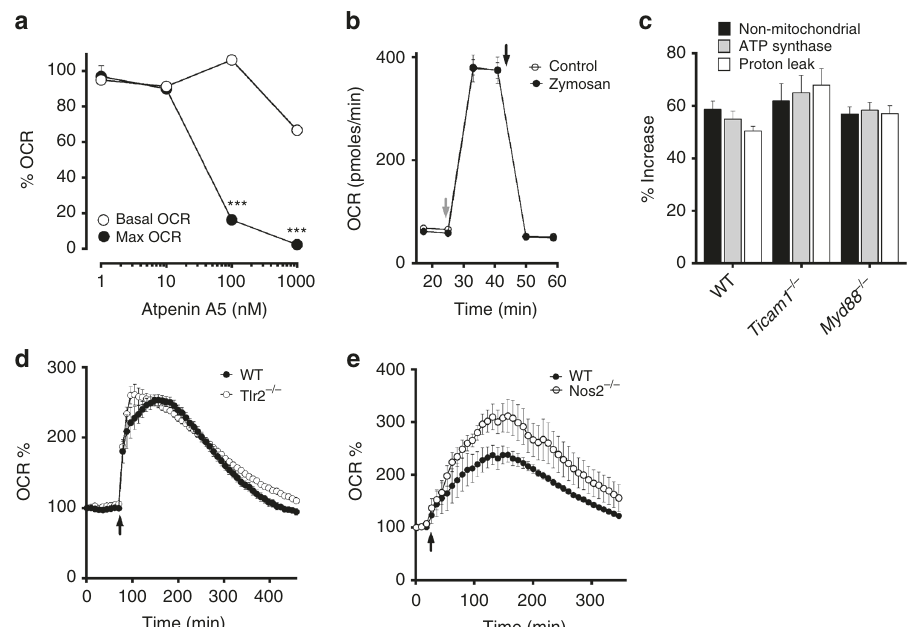
Fig. 6 The metabolic switch in peritoneal tissue-resident macrophages is independent of nitric oxide and TLR signalling. a Line graph showing relative changes in oxygen consumption rate (OCR) vs atpenin A5 dose in peritoneal tissue-resident macrophages (pTRMØ). Data are from a single experiment ( n = 5 – 6 separate wells per group), but the difference between basal and maximal OCR changes represents at least 3 experiments. b Line graph showing OCR vs time in pTRMØ. Cells were treated with or without zymosan (50 μ g/ml, 2 h) before metabolic fl ux analysis; cell membranes were permeablised and rotenone (200 nM) added, succinate (20 mM) was added at the grey arrow, and atpenin A5 (1 μ M) was added at the black arrow. Data represent at least two independent experiments and shows 6 separate wells per group. Data a , b were analysed by paired two-way ANOVA with Sidak ’ s post-tests. c Graph showing the increase in mitochondrial parameters from WT, MyD88 − / − and Ticam1 − / − pTRMØ calculated by comparing mock and zymosan treated samples as seen in Fig. 5b. Data show n = 6 separate wells per group from one experiment. d Graph showing OCR vs time, zymosan was added to wild- type (WT) and Tlr2 − / − pTRMØ at the arrow indicated. Data show n = 5 separate wells per group from one experiment. e Graph showing OCR vs time, zymosan was added to wild-type (WT) and Nos2 − / − pTRMØ at the arrow indicated. Data in the left panel show n = 5 separate wells per group pooled from two experiments. All error bars denote mean ±